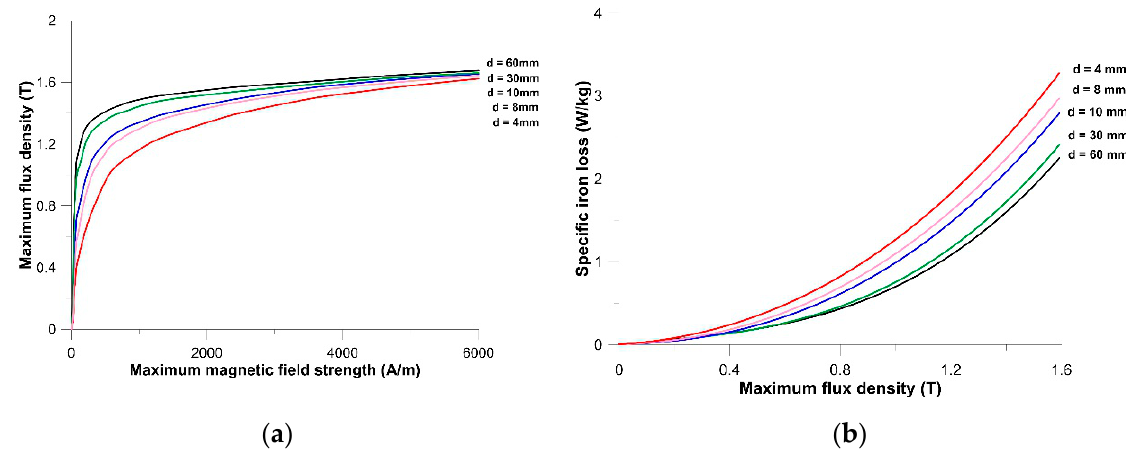
Figure 1. Measured curves for M250-35A material, cut at an angle of 0 degrees. The strip widths are shown in the image: ( a ) B vs. H ; ( b ) p vs. B at 50 Hz.